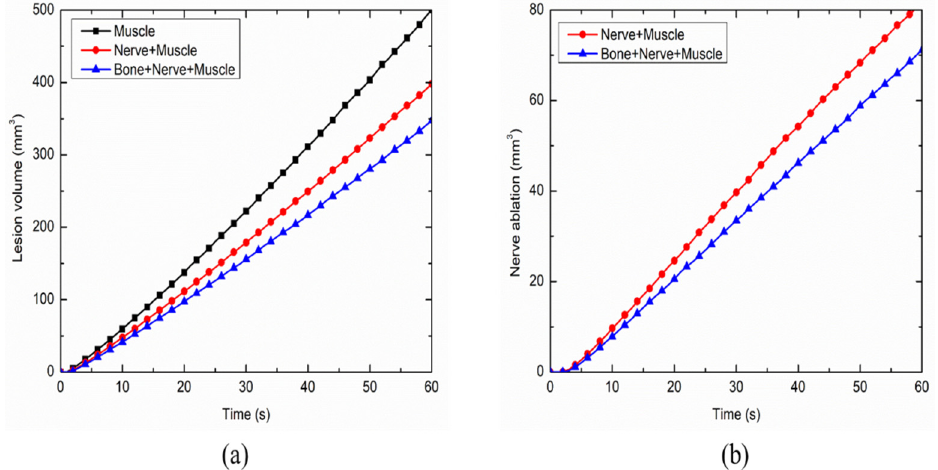
Figure 8. Variations in ( a ) total ablation volume, and ( b ) nerve ablation, with respect to time during the continuous RF procedure for pain relief among different considered cases.